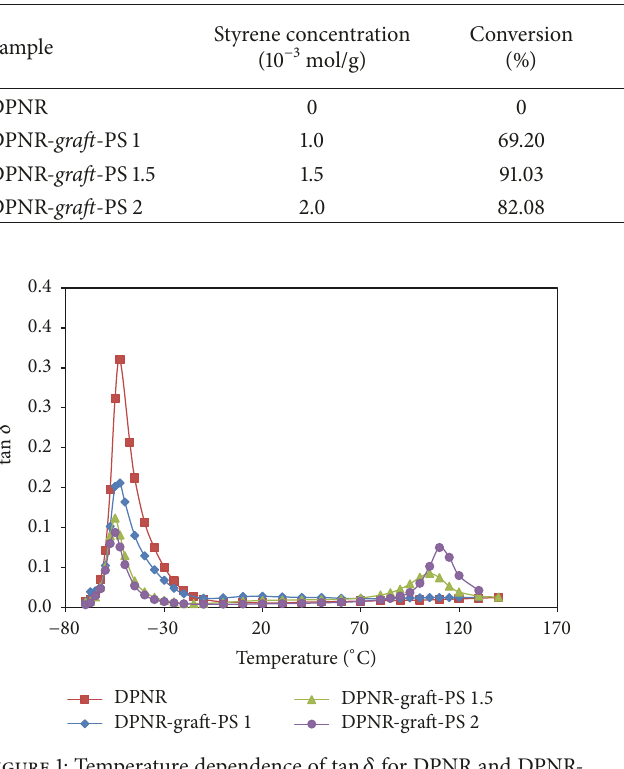
Table 1: The conversion and grafting efficiency of the graft copolymerization.